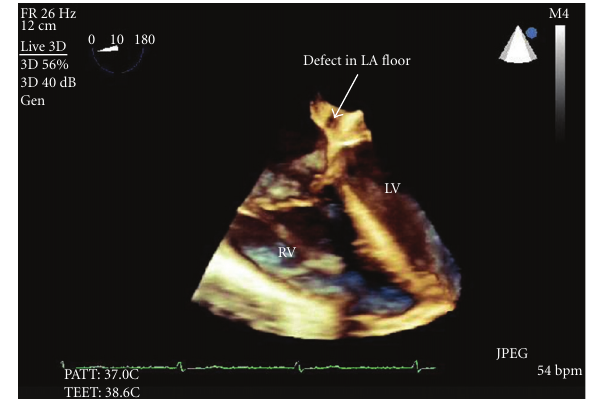
Figure 3: TEE. The left arrow indicates the interatrial septum, and the right arrow indicates the opening at the inferoposterior corner of the LA floor.